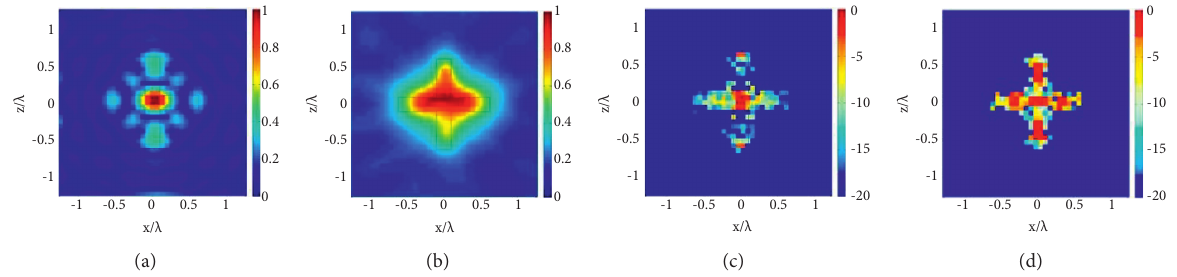
Figure 11: Reconstruction of the cross-shaped object a � 0.6 λ in xOy plane and φ -oriented dipoles. (a) TSVD, (b) LSM, (c) SSP, and (d) SHSP. SNR � 10